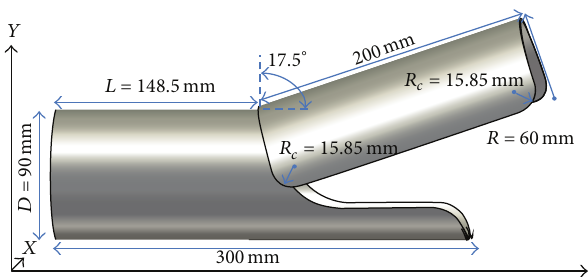
Figure 15: Enhanced Vlasov cut with a rotated optimized reflector with curved edges.